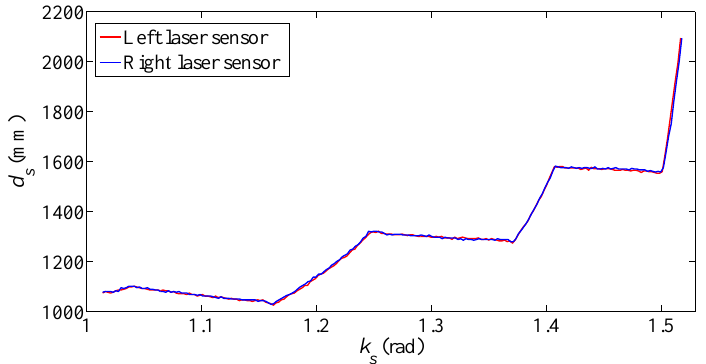
Figure 7. Distance measured during the scanning on the staircase surface before climbing up.